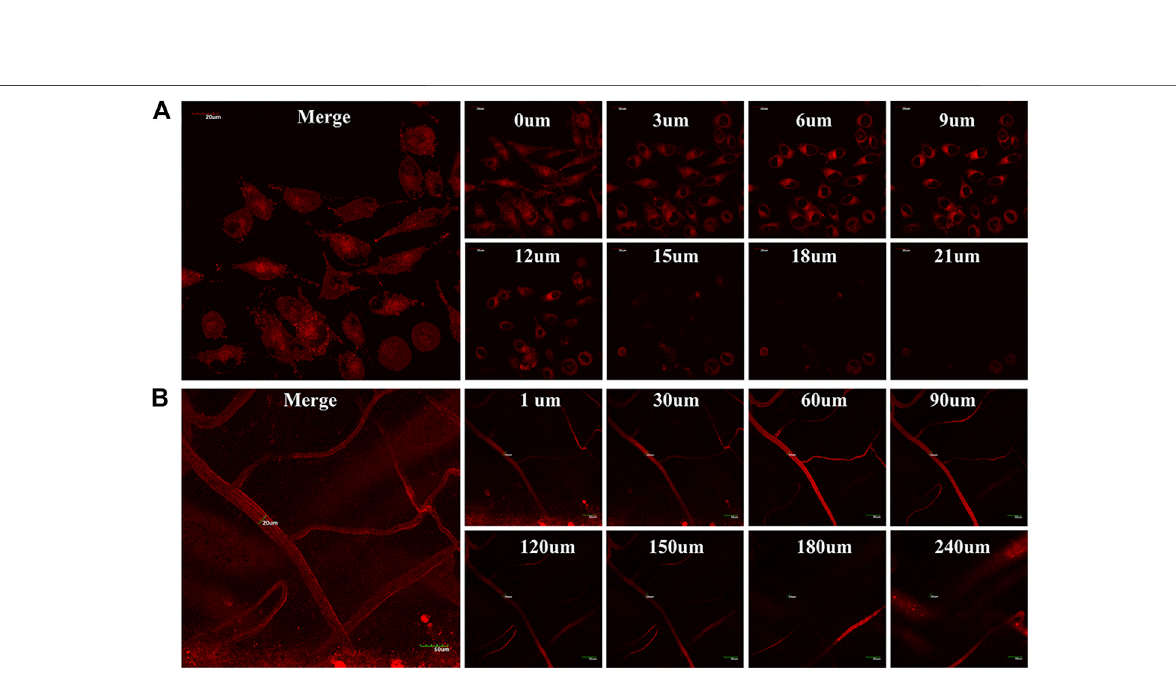
Frontiers in Chemistry |